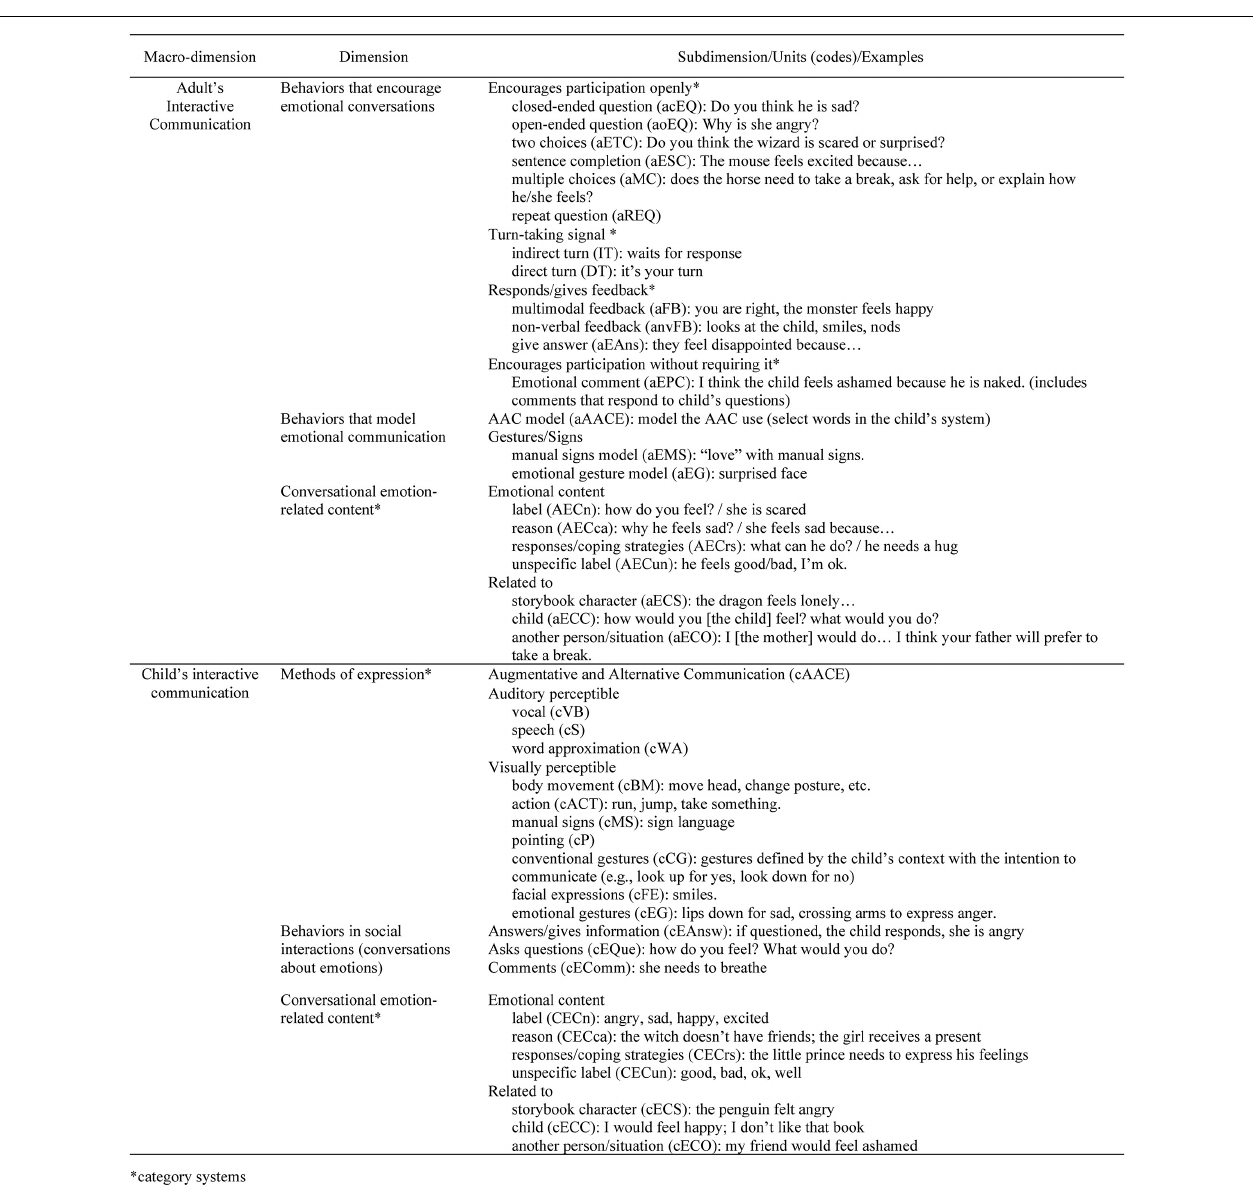
FIGURE 2 | Observation